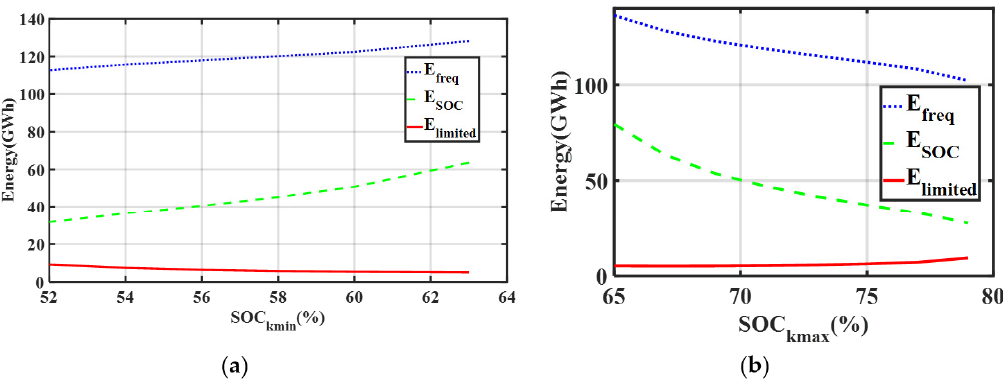
Figure 12. Objective function changes according to SOC operation min / max changes ( a ) Changes in SOC opmin ( b ) Changes in SOC opmax .